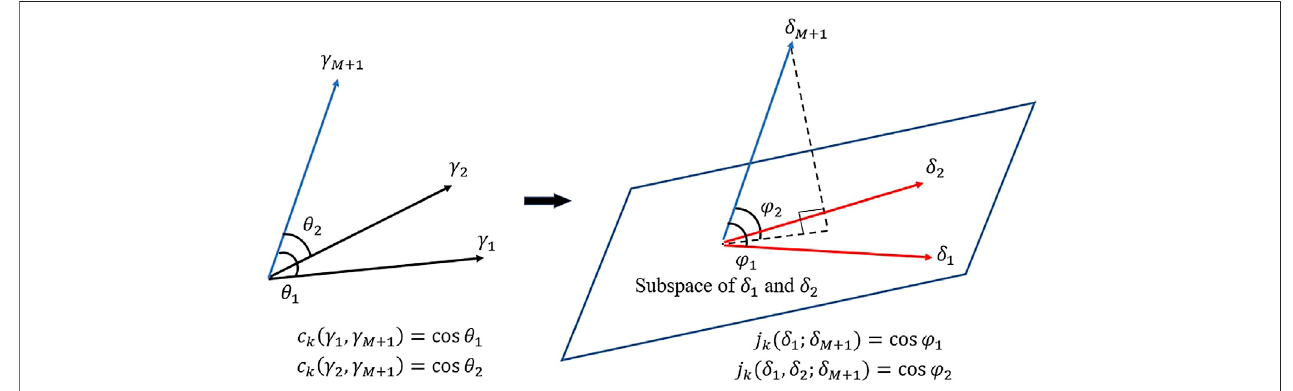
FIGURE 5 | Geometrical interpretation of j k value with two